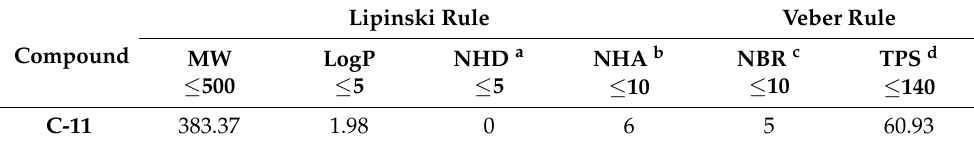
Table 4. Drug-likeness parameters estimated according to Lipinski and Veber